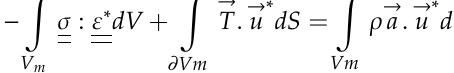
Table 1. Details on digital image correlation (DIC) set-up.